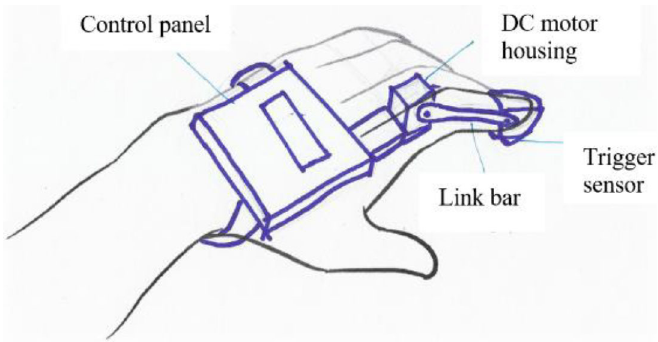
Figure 18. Concept 3 – Finger movements to trigger